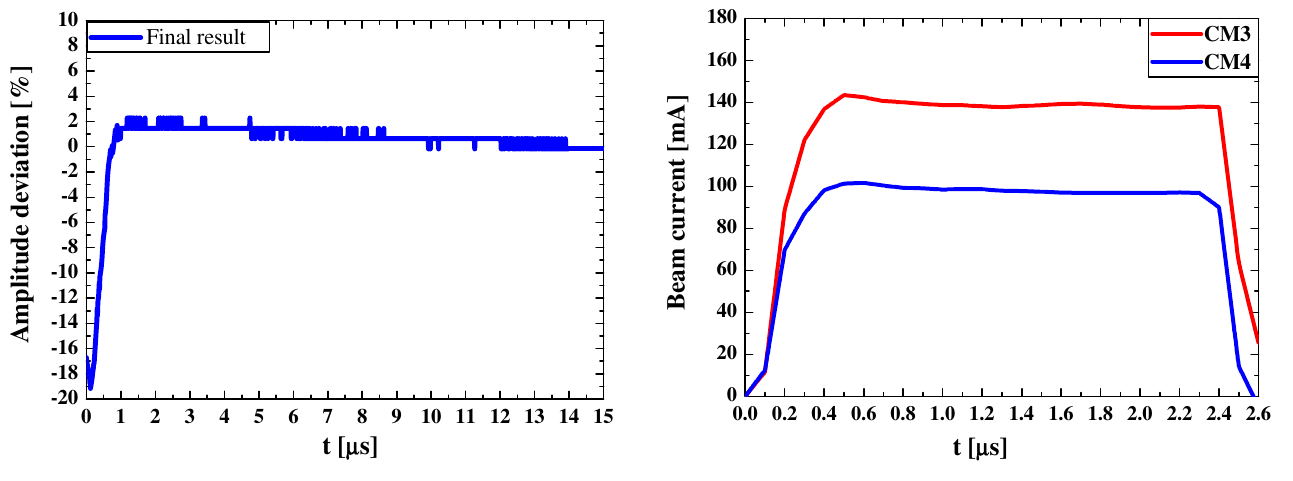
FIG. 14. (Color) Final result of deviation of output of klystron 2 from the target profile (amplitude